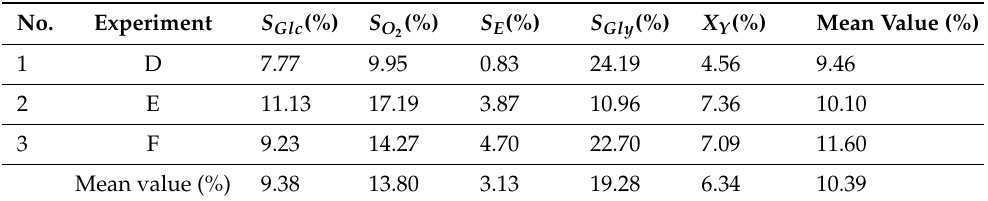
Table 6. Mean relative errors reported between model output and experimental data under aero- bic conditions.